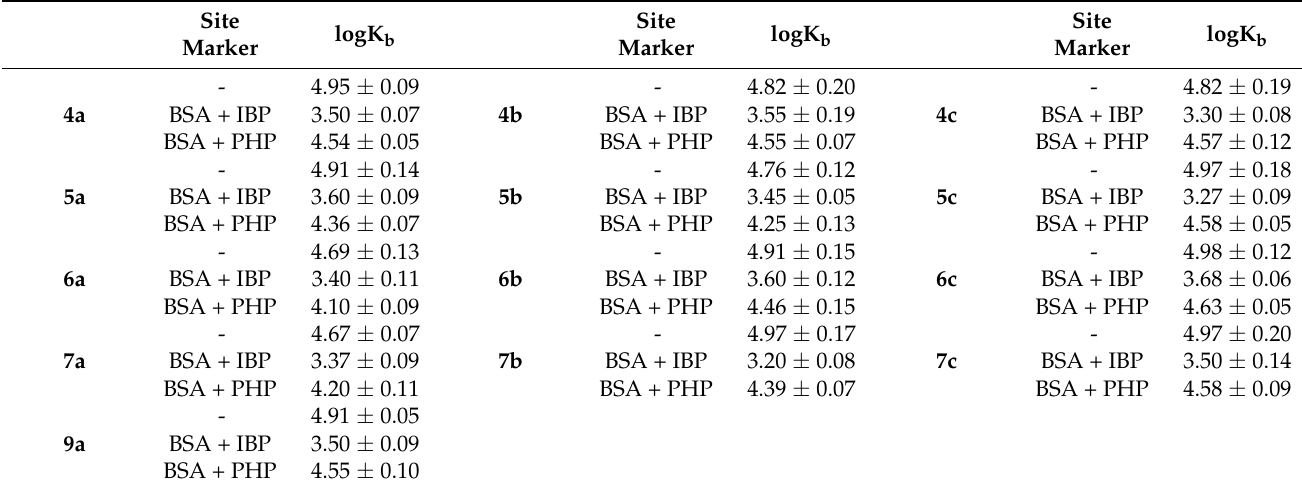
Table 7. The binding constant of the studied compounds with BSA in the presence of site markers Phenylbutazone (PHB) and Ibuprofen (IBP) at 297 K.